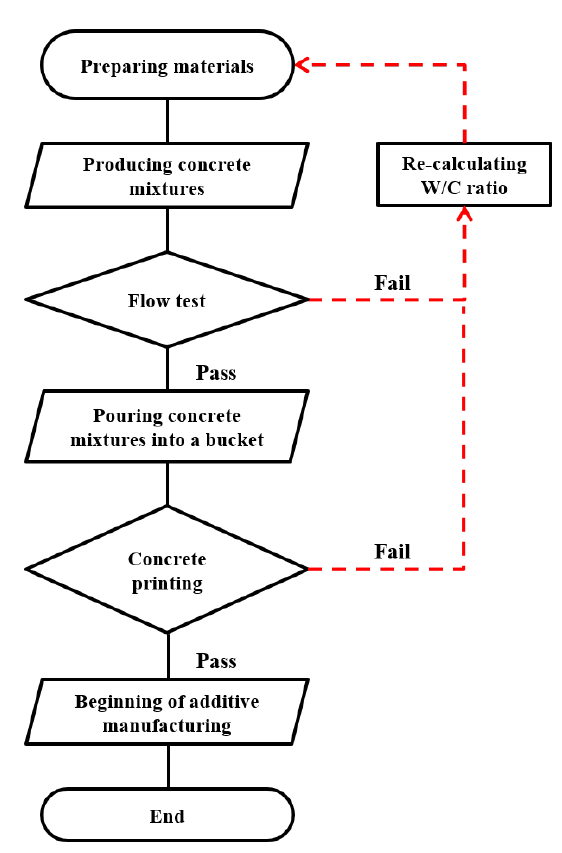
Figure 2. Additive construction by extrusion test procedure used in this study.